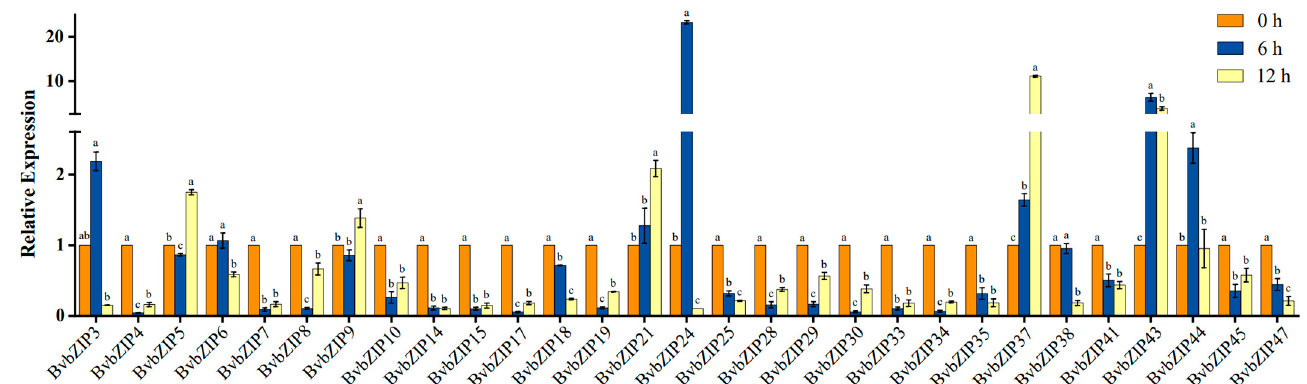
Figure 9. Expression patterns of the BvbZIP genes after salt stress. The beet root tissues treated with 200 mM NaCl were analyzed by qRT-PCR, and the sampling time was 0, 6 and 12 h. Each treatment corresponded to 3 biological replicates and 3 technical repeats. The control group was not treated with NaCl. The relative expression levels of 29 BvbZIP genes were calculated using the 2 −∆∆ Ct method. The 0 h expression level was used as a reference (relative expression level was 1), less than 1 was regarded as down-regulated expression, and greater than 1 was regarded as up-regulated expression. Data were analyzed by Duncan's analysis of variance, and different lowercase letters indicate differences in expression.